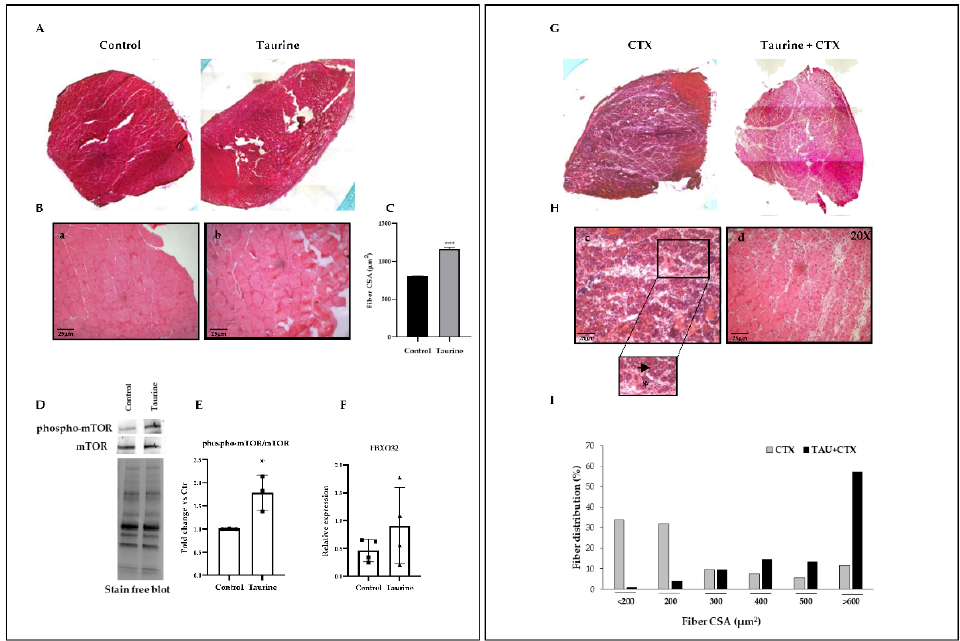
Figure 1. Taurine administration counteracts aging impingement of skeletal muscle regeneration. ( A , B , G , H ) Morphological analysis was performed by H&E staining of TA cross-sections derived from uninjured mice (panels a and b) and after CTX injections (panels c and d) in the presence or absence of taurine administration (original magnification × 20). ( C ) Morphometric analysis of the fiber cross- section area (CSA) of the TA muscles of control and taurine-treated mice after 5 weeks of treatment. ( I ) Histogram showing the percentage of distribution of the regenerating fiber cross-sectional areas in the injured TA muscles of control and taurine-treated mice after 1 week of regeneration. Regenerating fibers are highlighted by an arrow; necrotic fibers are highlighted by an asterisk. ( D ) Western blotting analyses of total lysates were achieved to evaluate the expression levels of phospho-mTOR and mTOR. A representative blot is shown. ( E ) The graph shows the densitometric analysis of the ratio between phospho-mTOR/mTOR levels performed by using a stain-free blot to verify the sample loading. ( F ) Real-time PCR analysis of FBXO32 levels in the TA muscles of the control and taurine- treated mice. All the values referring to the morphometric analysis were obtained using the ImageJ analysis software. ( C , I ) Statistical analysis was performed with the Mann–Whitney rank-sum test, *** p < 0.001. ( E , F ) Statistical analysis was performed using Student’s t -test. * p < 0.05. n ≥ 3 mice per group. Data are represented as mean ± SEM. ( E ) • and (cid:4) represent samples from Control and Taurine-treated groups, respectively; ( F ) (cid:4) and (cid:78) represent samples from Control and Taurine-treated groups,